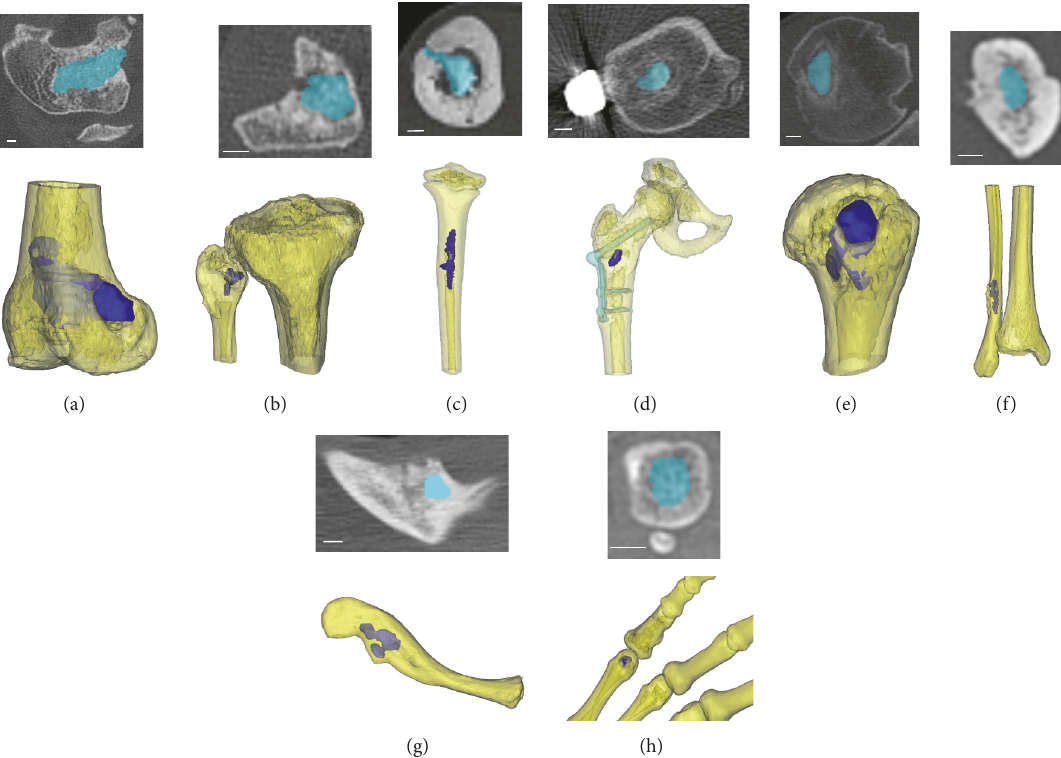
Figure 3: Representative axial CT and 3D reconstructed images of remaining TCP (blue) at 1-year postop for distal femur (a), proximal fibula (b), proximal tibia (c), proximal femur (d), proximal humerus (e), distal fibula (f), clavicle (g), and metacarpal (h).